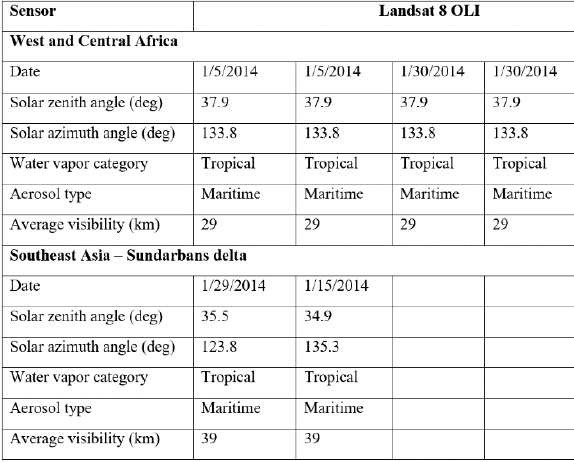
Table 1. Parameters used for atmospheric correction